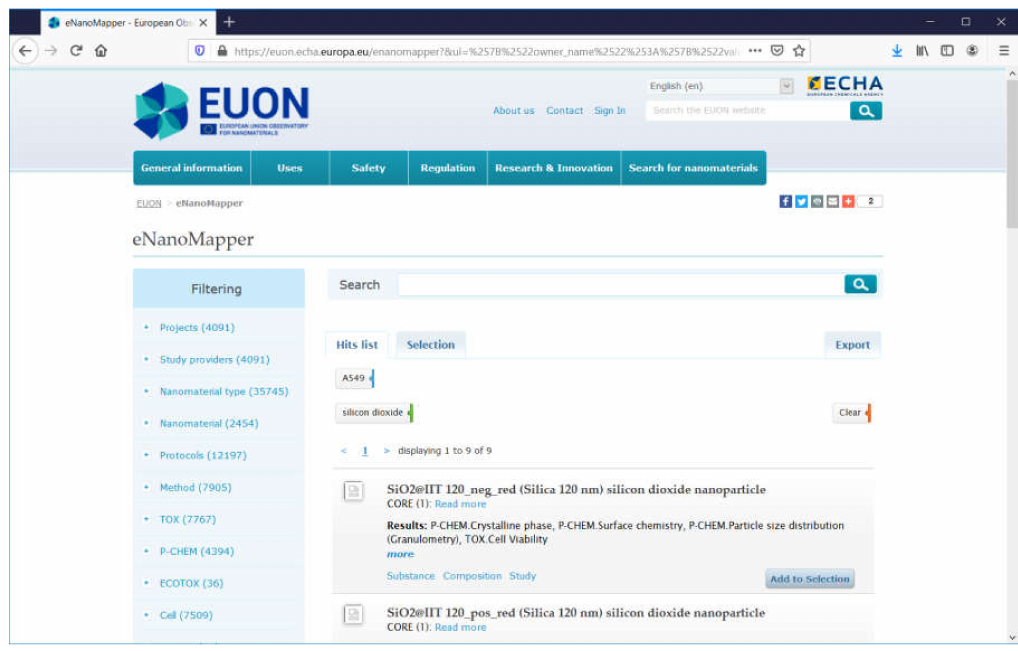
Figure 12. Screenshot of the EUON eNanoMapper database: result from a faceted search for records with silicon dioxide NM and experiments with cell lines